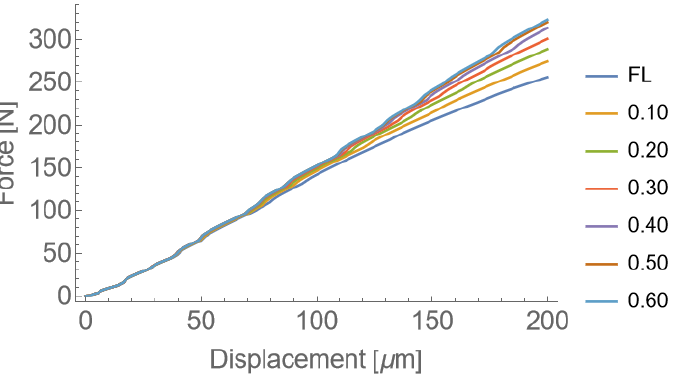
Figure 12. The sensitivity of load–displacement curves with varying Coulomb friction coefficient (FL denotes the frictionless case).